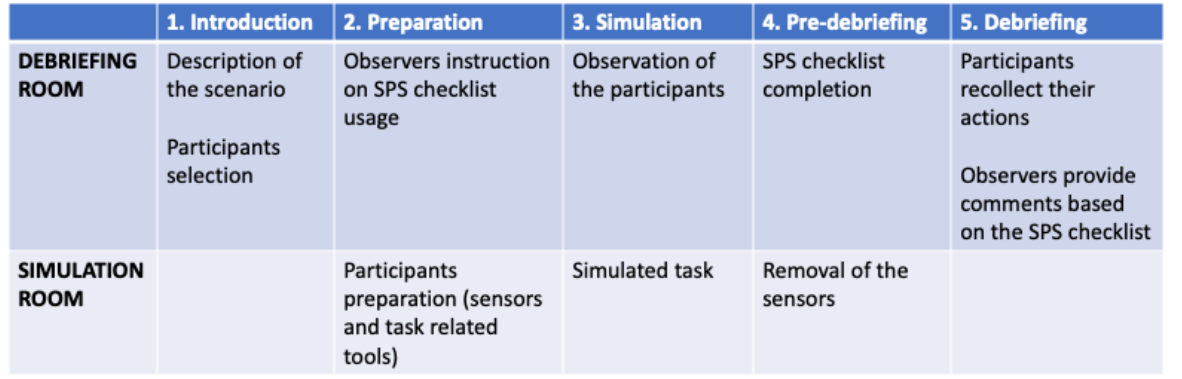
Figure 4. The view from the monitor in the debriefing room.